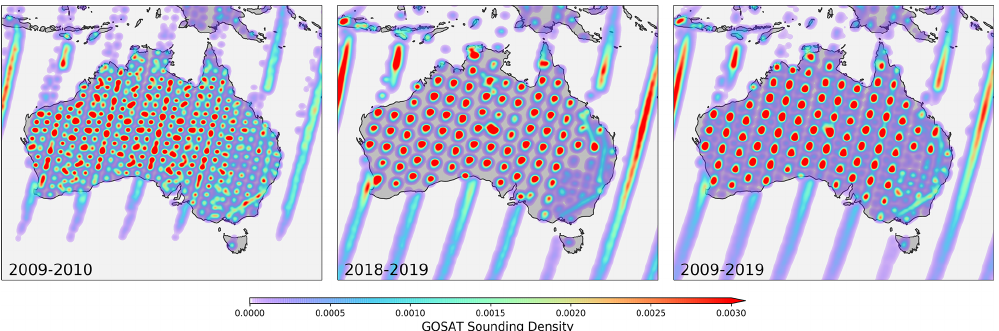
Figure E2. Figure contrasting the sampling density pattern over Australia for early in the mission versus recent years. The five-point sampling grid as used in the early years of the missions was updated to a more stable three-point grid which continues to be used. The change in pointing mechanism has allowed the ocean sun-glint measurement range to be